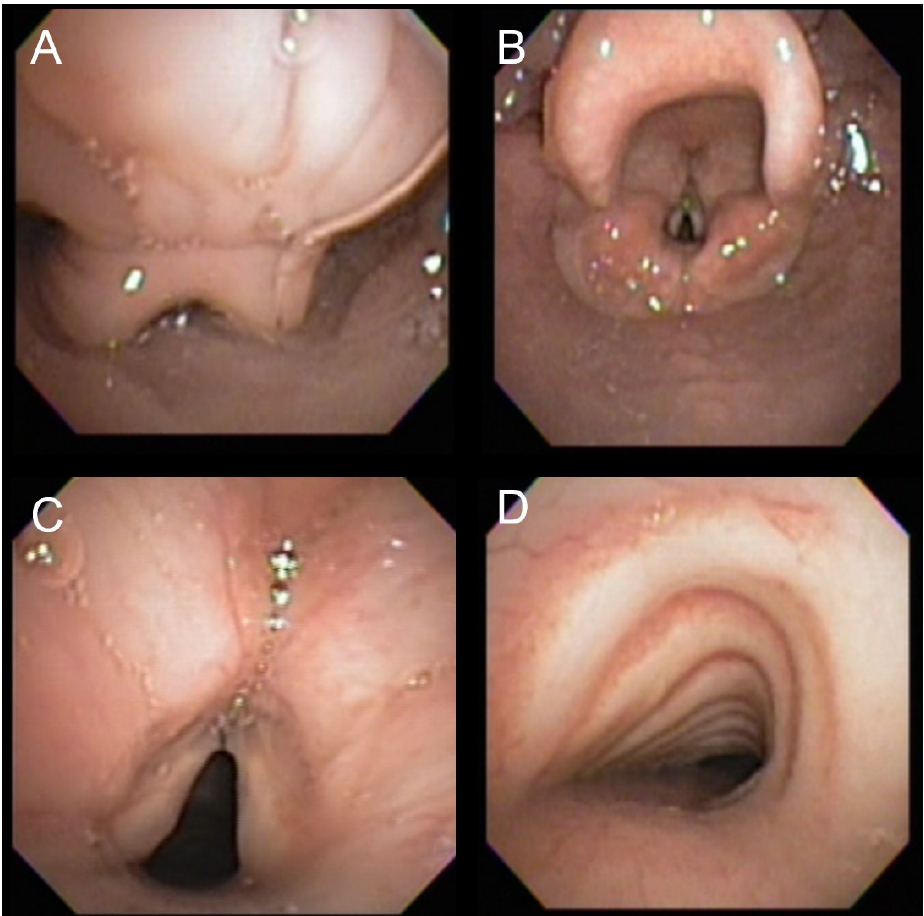
Figure 1. Airway scoring. ( A ) Shows moderate pharyngeal collapse, which would be +2 on the score. ( B ) Shows epiglottal thickening which would be +1 on the score, and mild arytenoid thickening, which would be +1 on the score. ( C ) Shows vocal cord thickening, which is not a finding incorporated into the airway severity score, but is clinically relevant and was inconsistently reported. ( D ) Shows moderate tracheopathy which would be a +2 on the score. Therefore, the total airway severity score for this bronchoscopy would be